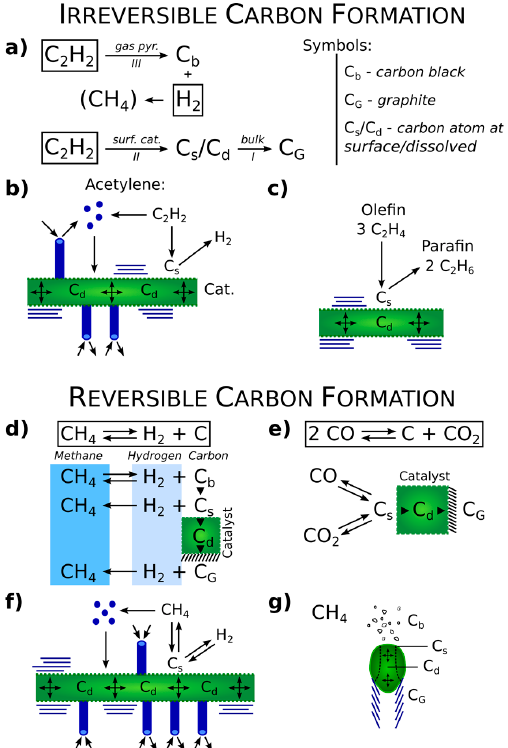
Figure 1. Scheme showing the important operational difference between irreversible ( a – c ) and